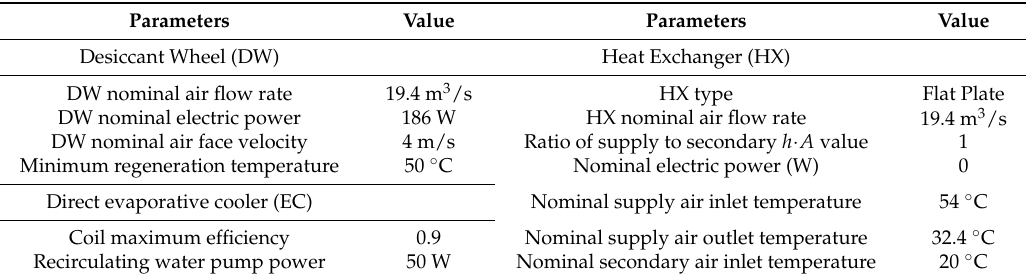
Table 6. Simulation input parameters for the desiccant cooling subsystem components